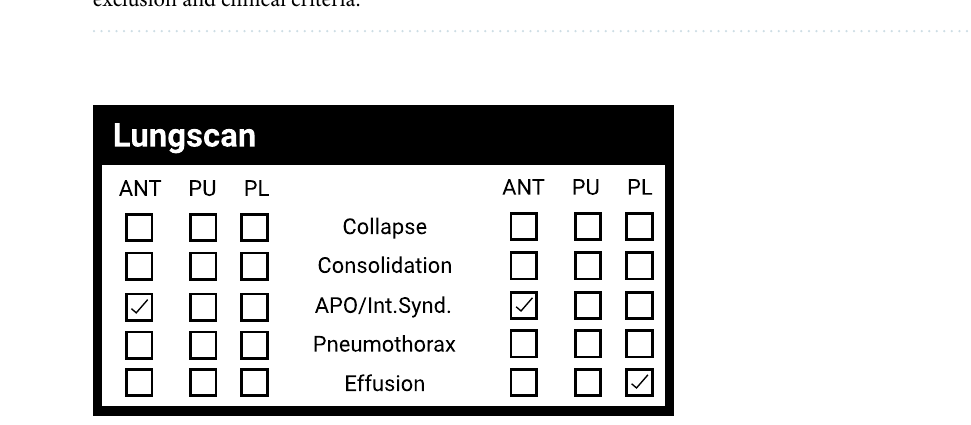
Table 3. Describes the consolidation/collapse dataset distribution before and after application of the data exclusion and clinical criteria.